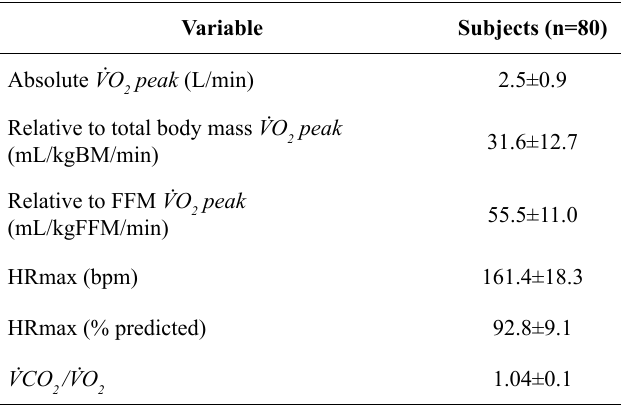
Table 1. Results obtained from cardiopulmonary exercise test